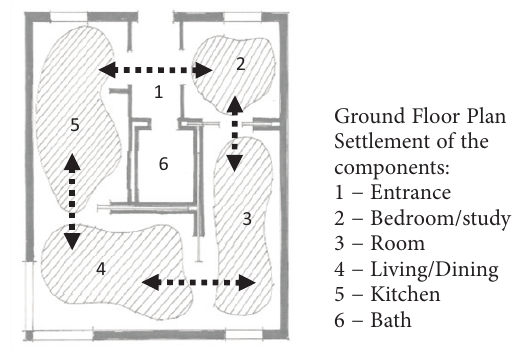
Figure 1. The soft Connection in the form of the portable walls in sample 27, ‘Affordable Rural Housing’, Britain, 2000,